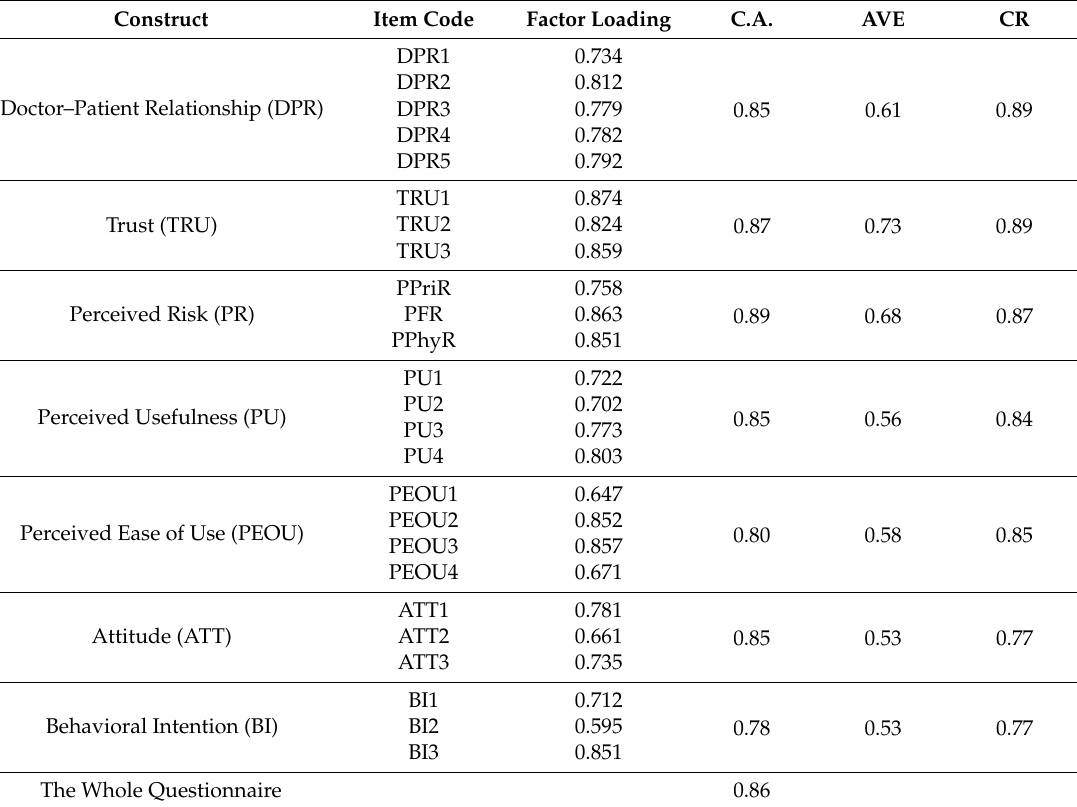
Table 2. Factor Loading, C.A., AVE, and